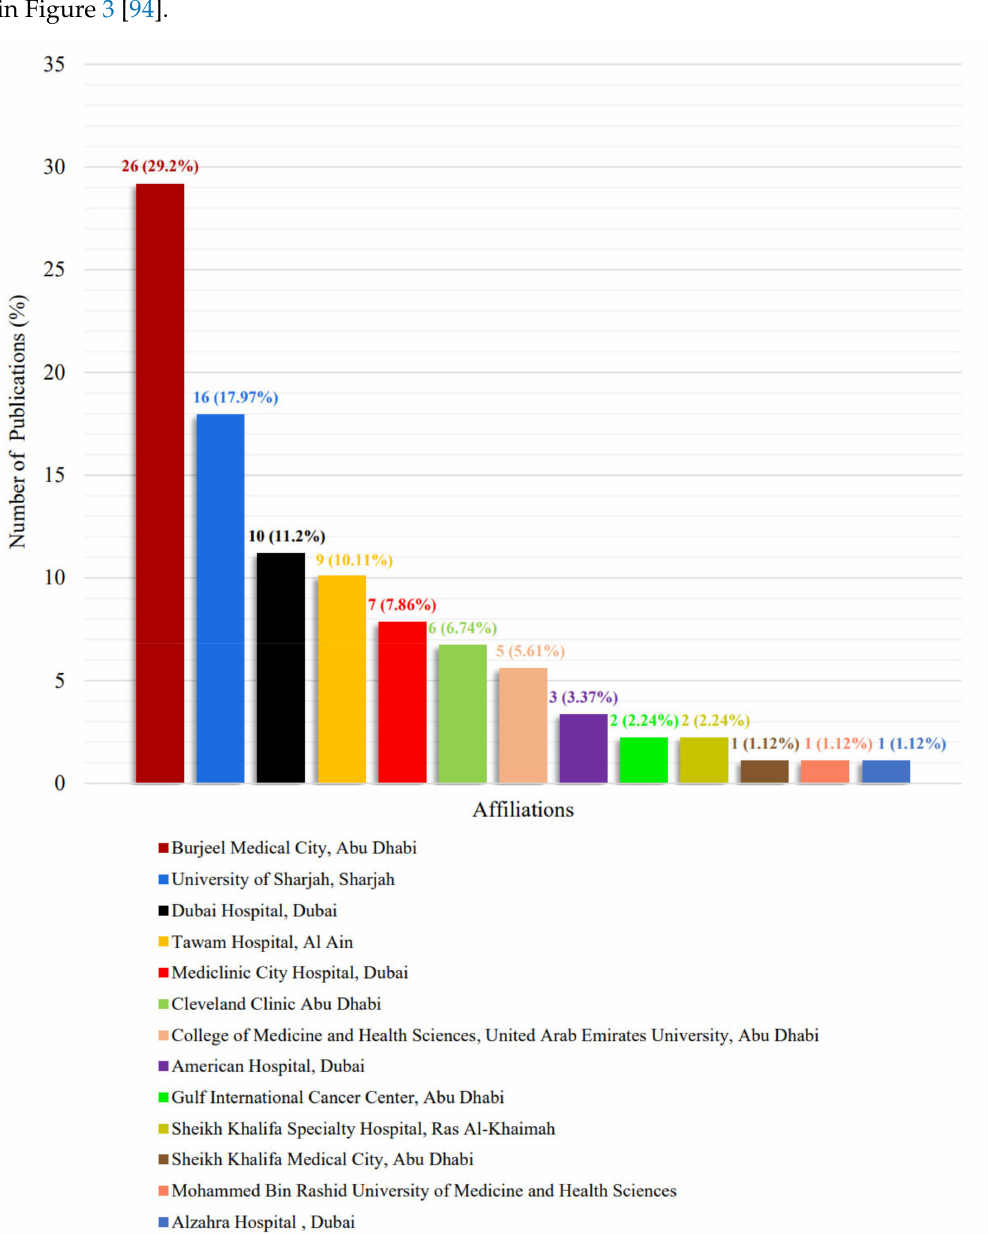
Figure 3. The ranking of cancer centers based on their cancer research output in